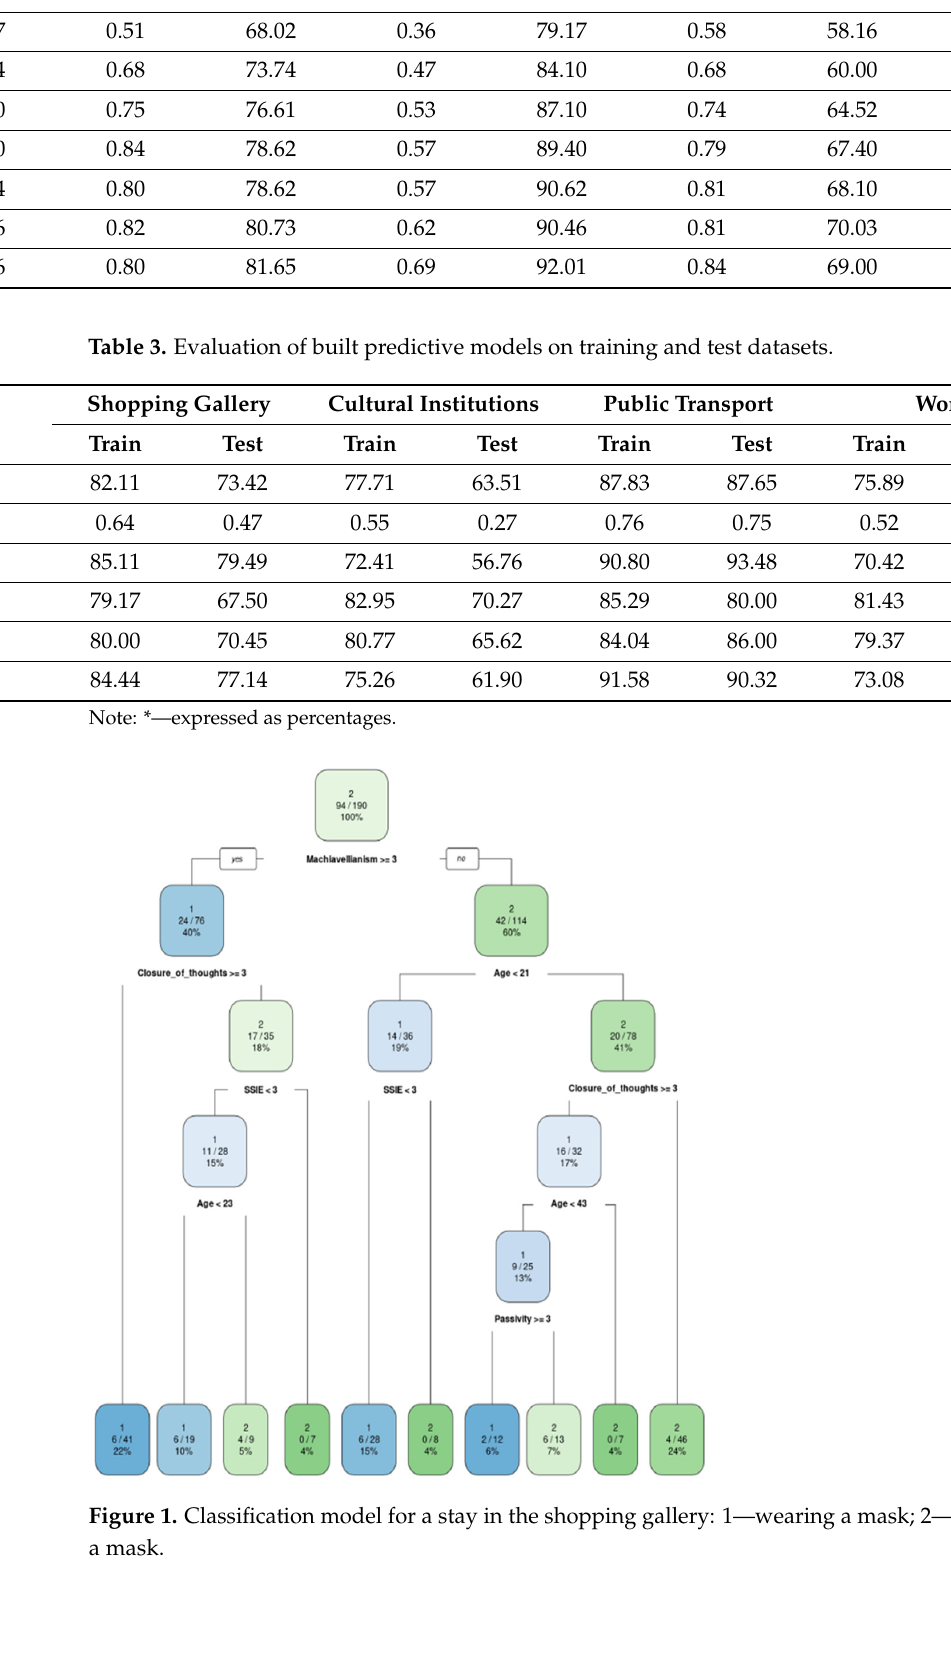
Figure 2. Classification model for a stay in the cultural facilities: 1—wearing a mask; 2—not wear- ing a mask.